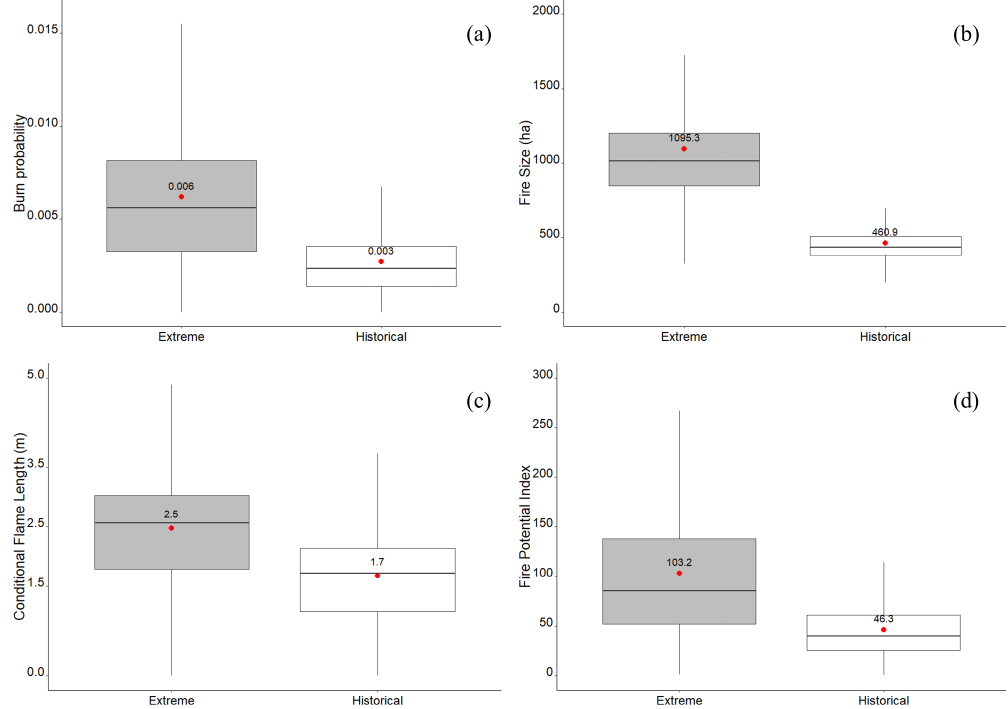
Figure 4. Distribution of extreme and historical estimated wildfire descriptors: (a) burn probability (BP), (b) fire size (FS), (c) conditional flame length (CFL) and (d) fire potential index (FPI). Red points represent averaged values.